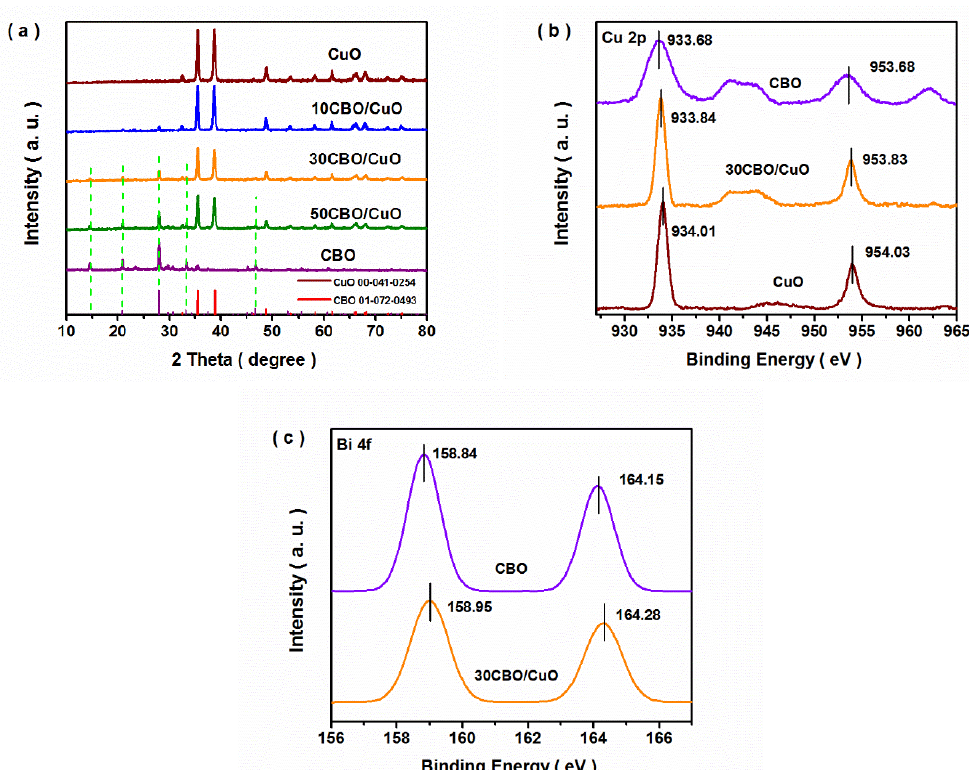
Figure 1. XRD patterns ( a ) and XPS spectra (( b ) Cu 2p and ( c ) Bi 4f) of the as-prepared samples. The morphologies of the as-prepared CuBi 2 O 4 , CuO and 30CBO/CuO samples were visualized via SEM and TEM characterizations. The SEM images in Figure 2a–c demon- strated that all the samples exhibited the typical particle morphology. Concurrently, a lot of voids were formed due to piles of particles, leading to large exposed surfaces. TEM